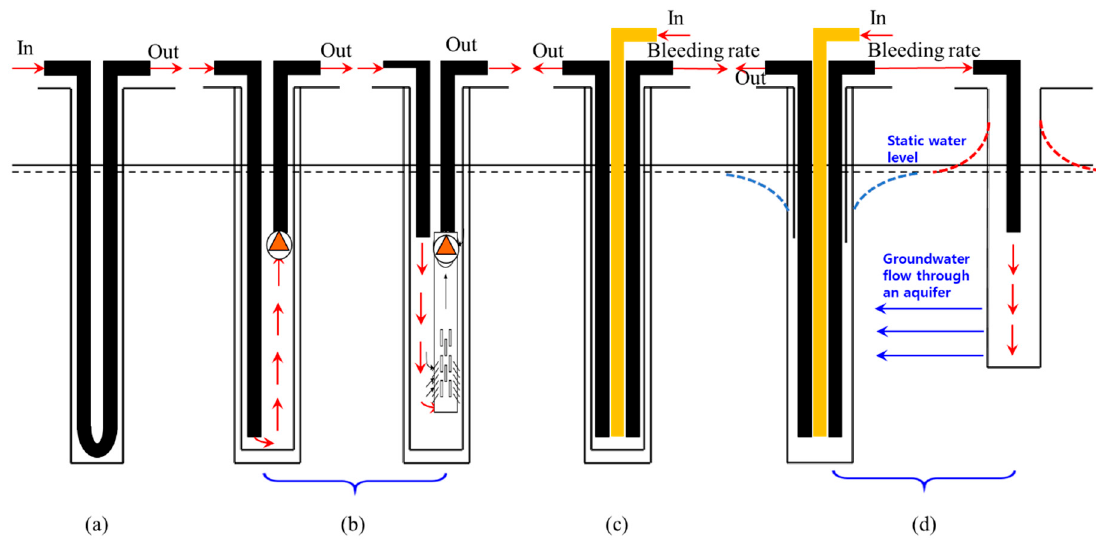
Figure 5. Schematic diagrams of a geothermal heat exchanger system: ( a ) closed loop; ( b ) SCW with return pipe location; ( c ) single-well SCW with bleeding rate; ( d ) two-well SCW system.